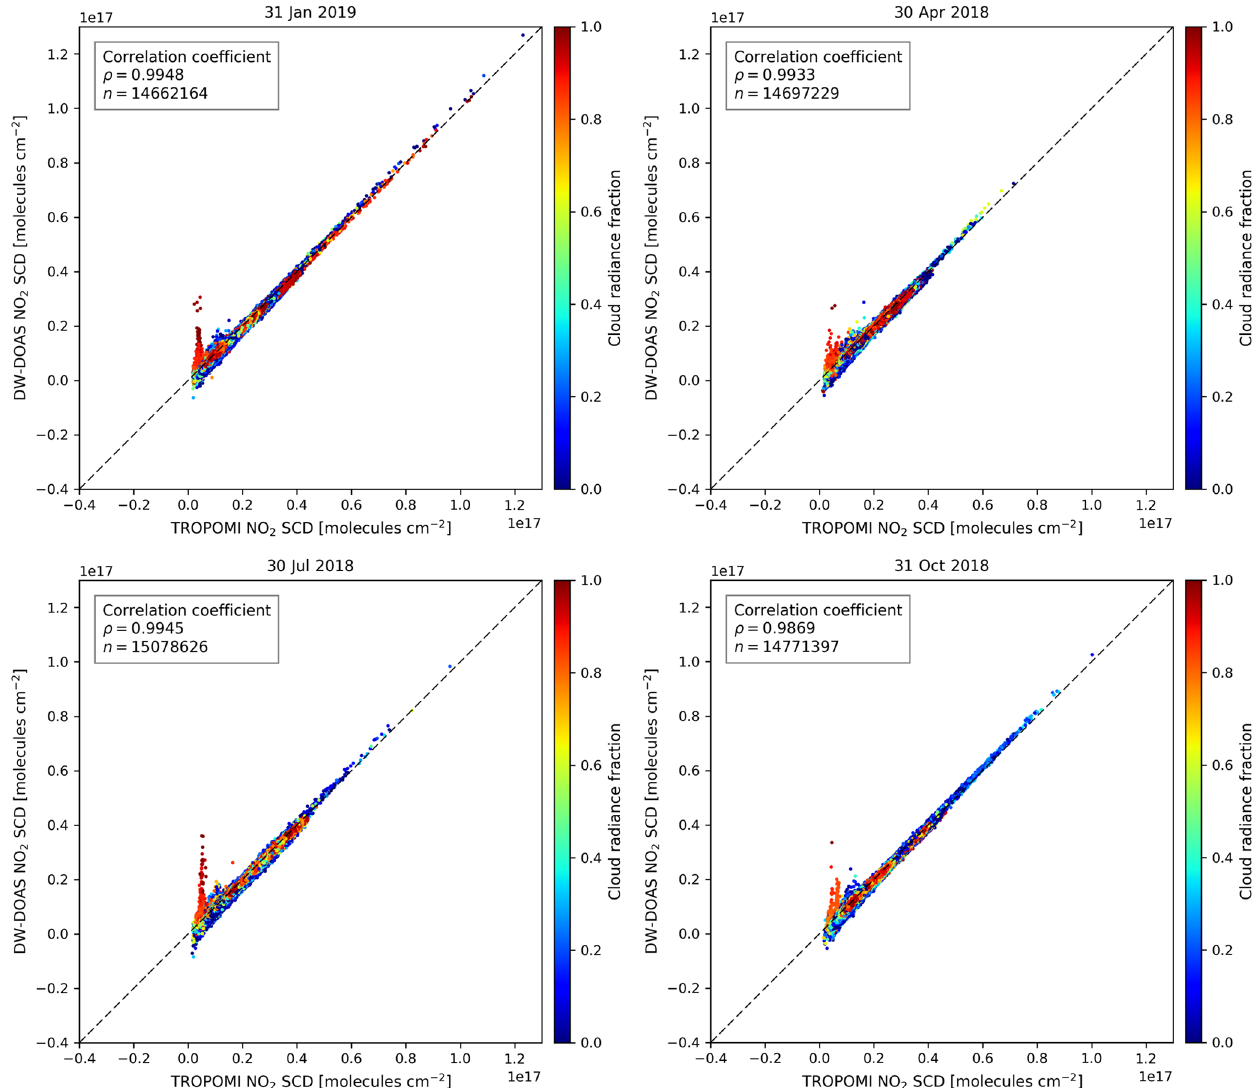
Figure 10. Correlation plots of DW-DOAS and TROPOMI global NO 2 SCD data used in Fig. 9. Pixels in the region affected by the SAA (approximated by a rectangle of latitudes [6 ◦ S, 40 ◦ S] and longitudes [70 ◦ W, 16 ◦ W]) have been filtered